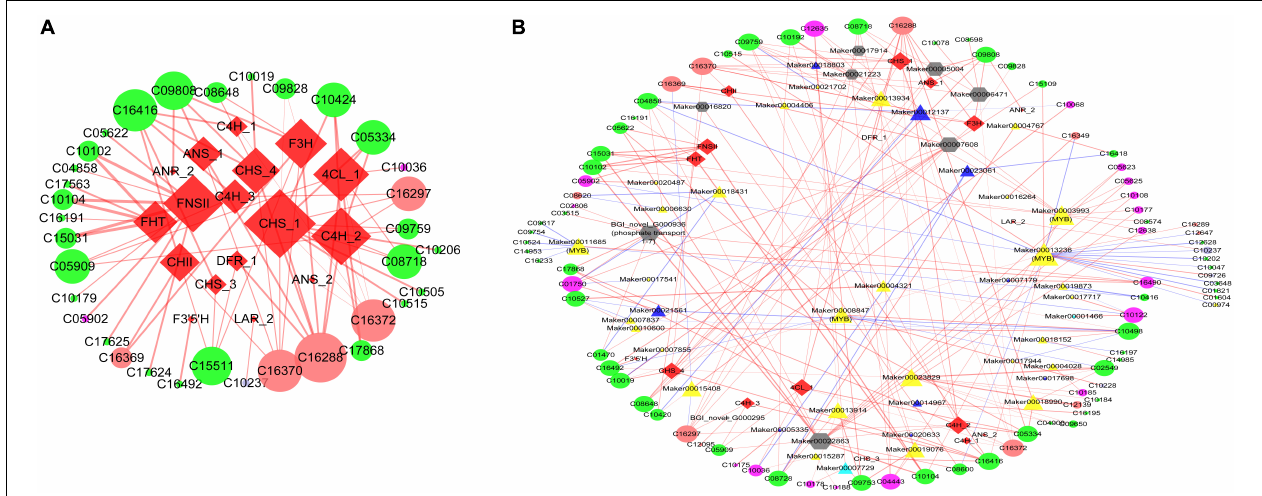
FIGURE 7 | Connection network between flavonoid biosynthesis related genes and flavonoids. (A) Connection network between flavonoid biosynthesis structural genes and flavonoids; (B) connection network between flavonoids and MYBs, bHLHs, WDRs, transport genes, and structural genes. The magenta circle represents flavonols; the Indian red circle represents anthocyanins; the gray violet circle represents proanthocyanidins; the green circle represents other flavonoids; the red diamond represents the structural genes; the triangle represents TFs, the yellow triangle represents MYB families, the blue triangle represents bHLH families, the Caribbean green triangle represents WDR families; the gray hexagon represents transport genes. The size of the shapes in the graph shows the number of connections of the input genes and flavonoids in the network. The red line indicates a positive correlation, and the blue line indicates a negative